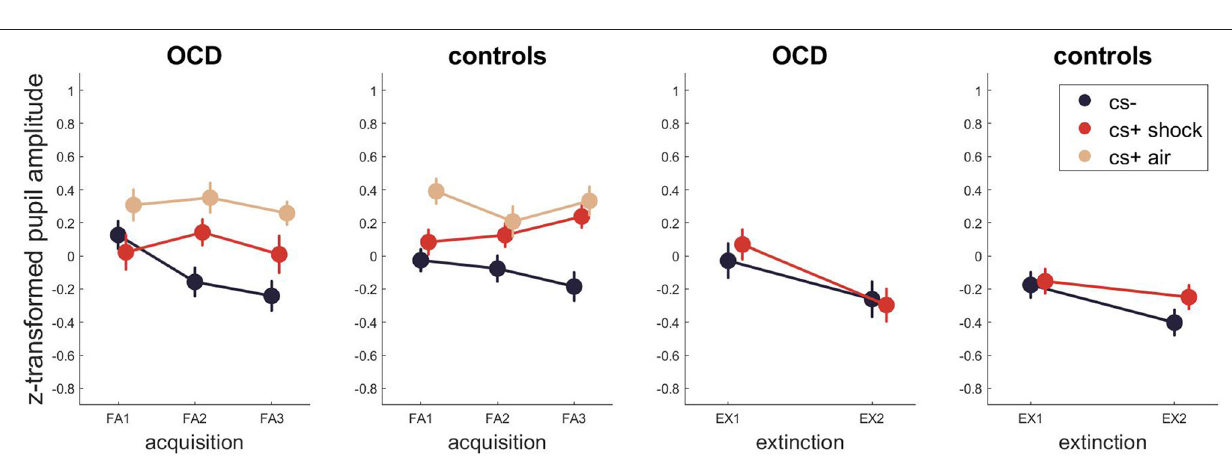
Frontiers in Psychiatry |